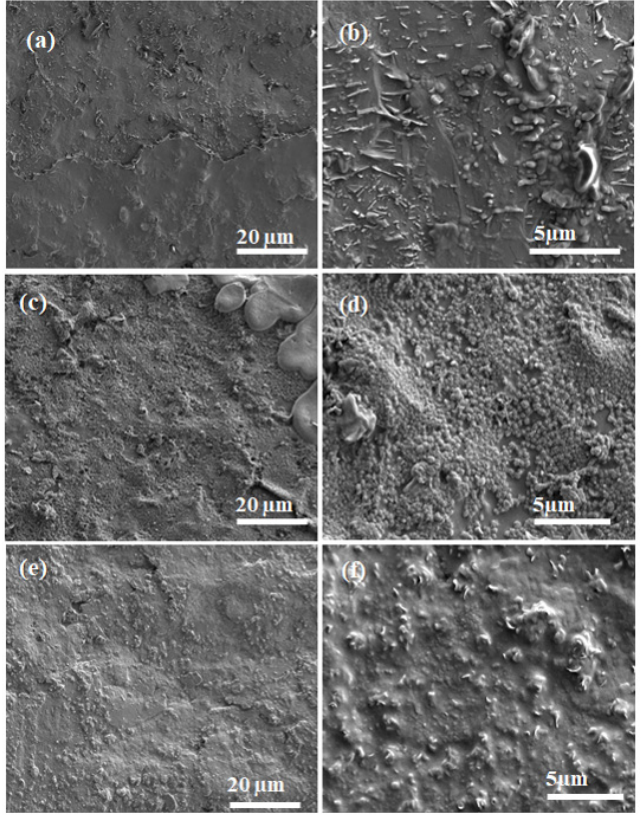
Figure 5. SEM image of G.C ( a , b ), PANI-deposited @G.C ( c , d ), and PANI@G.C with POX ( e , f ).